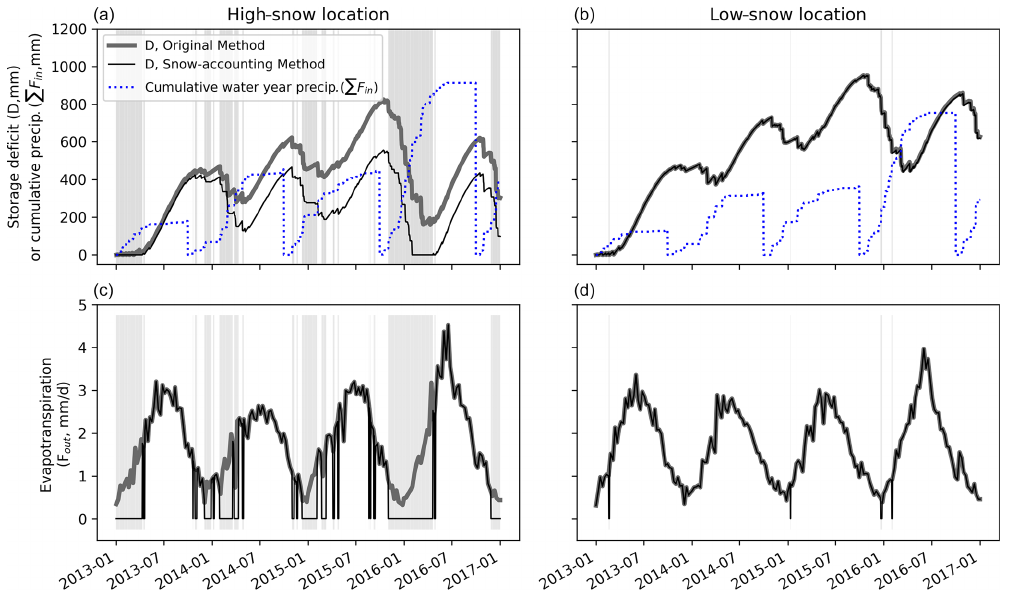
Figure 2. Storage deficit time series for representative “high-snow” and “low-snow” locations in the Sierra Nevada (locations mapped in Fig. 1) from 2013 through 2016, showing the difference between the original and snow-accounting methods. Cumulative water year precipitation (instantaneous precipitation is F in ) is plotted in dotted blue in panels (a) and (b) , and ET ( F out ) is plotted in panels (c) and (d) , where the snow-accounting method takes F out = 0 during periods of snow cover (gray shading in background). During snow-free periods (white background), deficits change identically (though there may be a vertical offset). During periods when snow is present, the new method prevents deficit growth, whereas the deficit may grow during snowy periods using the original method (e.g., January 2015). The plot demonstrates how the original method may lead to a larger estimate of S R (computed as the maximum value of D ) in snow-dominated